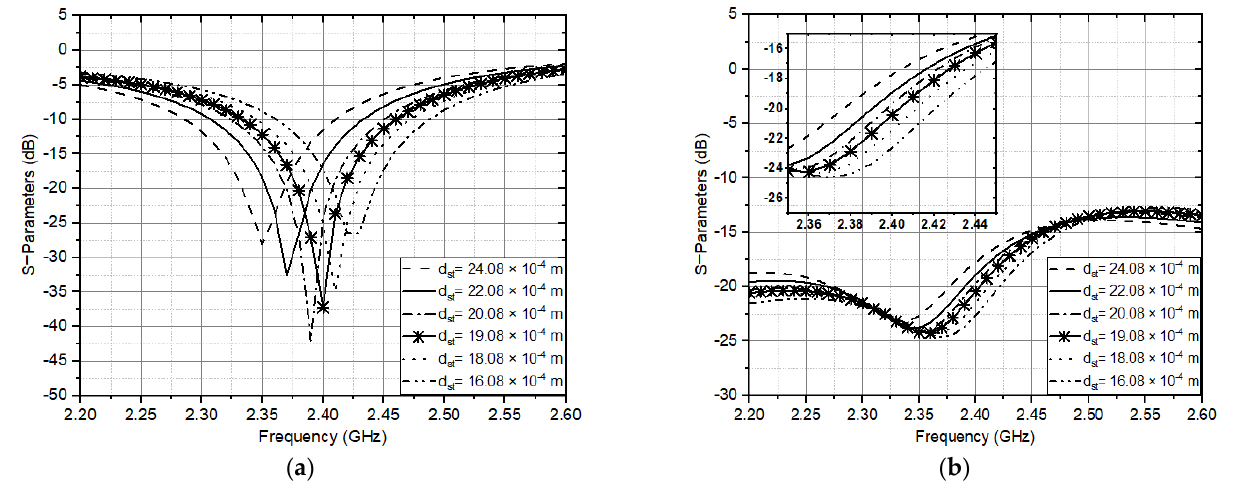
Figure 4. Arrangement S parameter calculation to the dimensions of the double U slot on ( a ). S11 on port 1 ( b ). S21 on port 2.